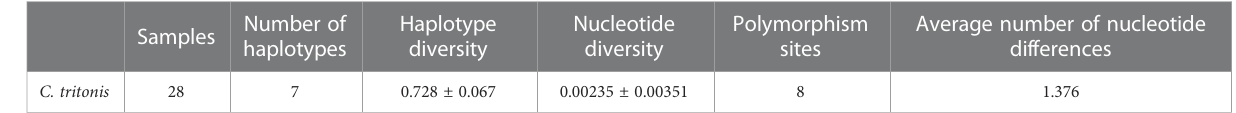
TABLE 4 Genetic diversity based on COI gene sequences of C. tritonis